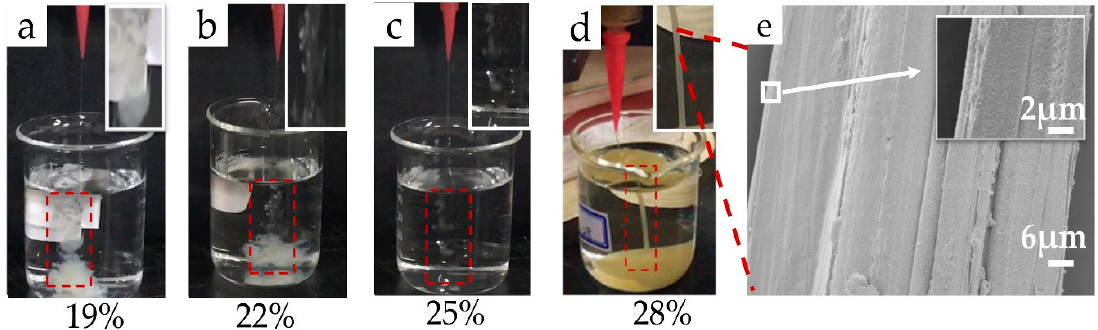
Figure 10. ( a – d ) E ff ect of concentration on the dry-wet spinnability of the RSF solutions; ( e ) Morphology Figure 10. (a–d) Effect of concentration on the dry-wet spinnability of the RSF solutions; (e) of the RSF fibers Morphology of the RSF fibers (28-E2).